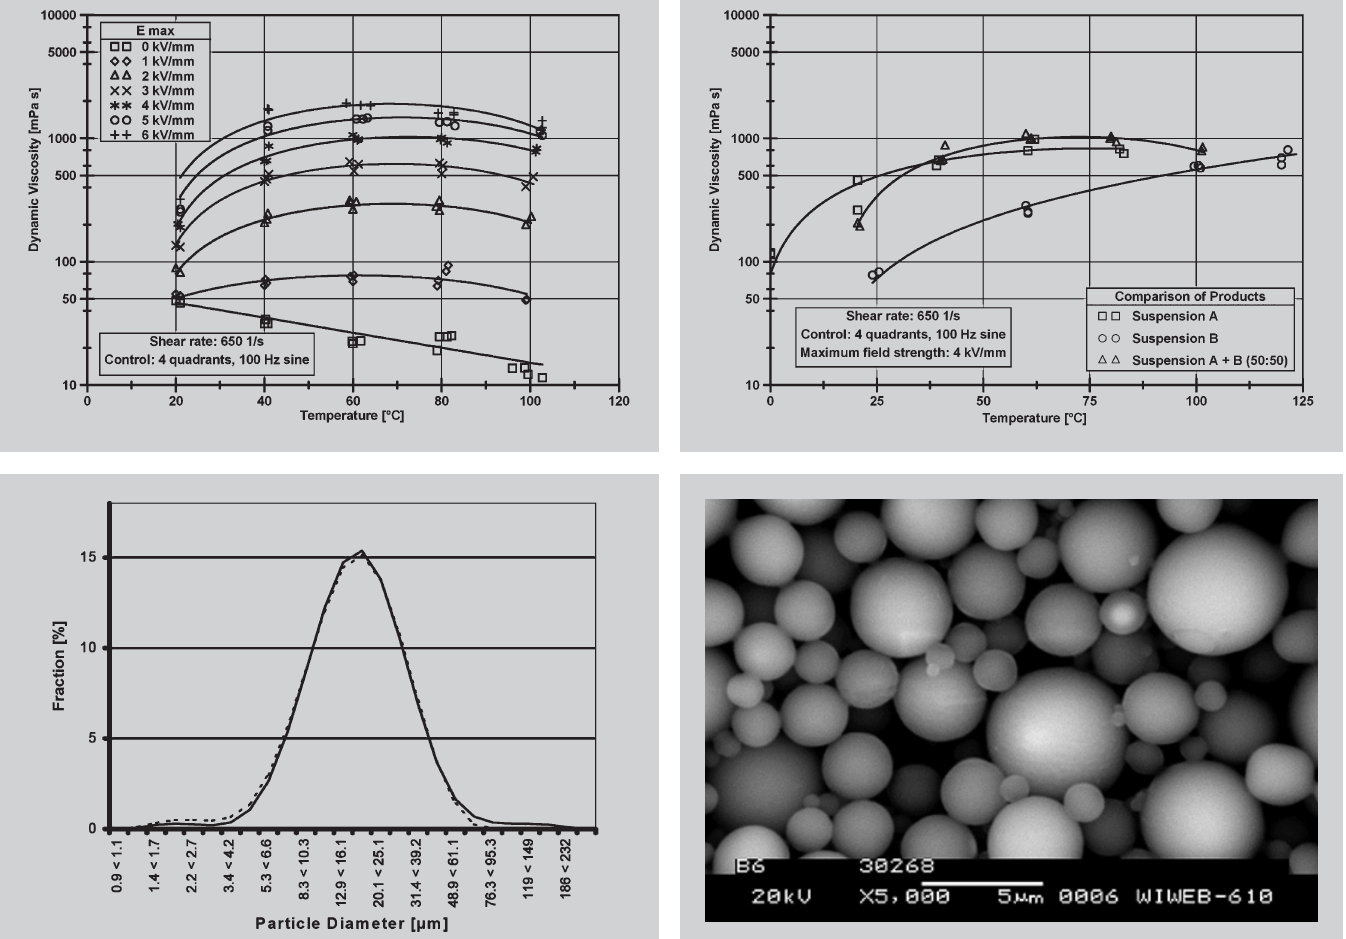
Figure 6 (left above): V-T behavior of the mixture: Suspension A and B exposed to the electric field [3]. Figure 7 (right above): Comparison of the V-T behavior of ERF at 4 kV/mm [3]. Figure 8 (left below): Particle size distribution of suspension A and B (dotted line) measured by LALLS. Figure 9 (right below): Exemplary scanning elec- tron microscopic display of polyurethane-based parti- cles taken from ER suspen-